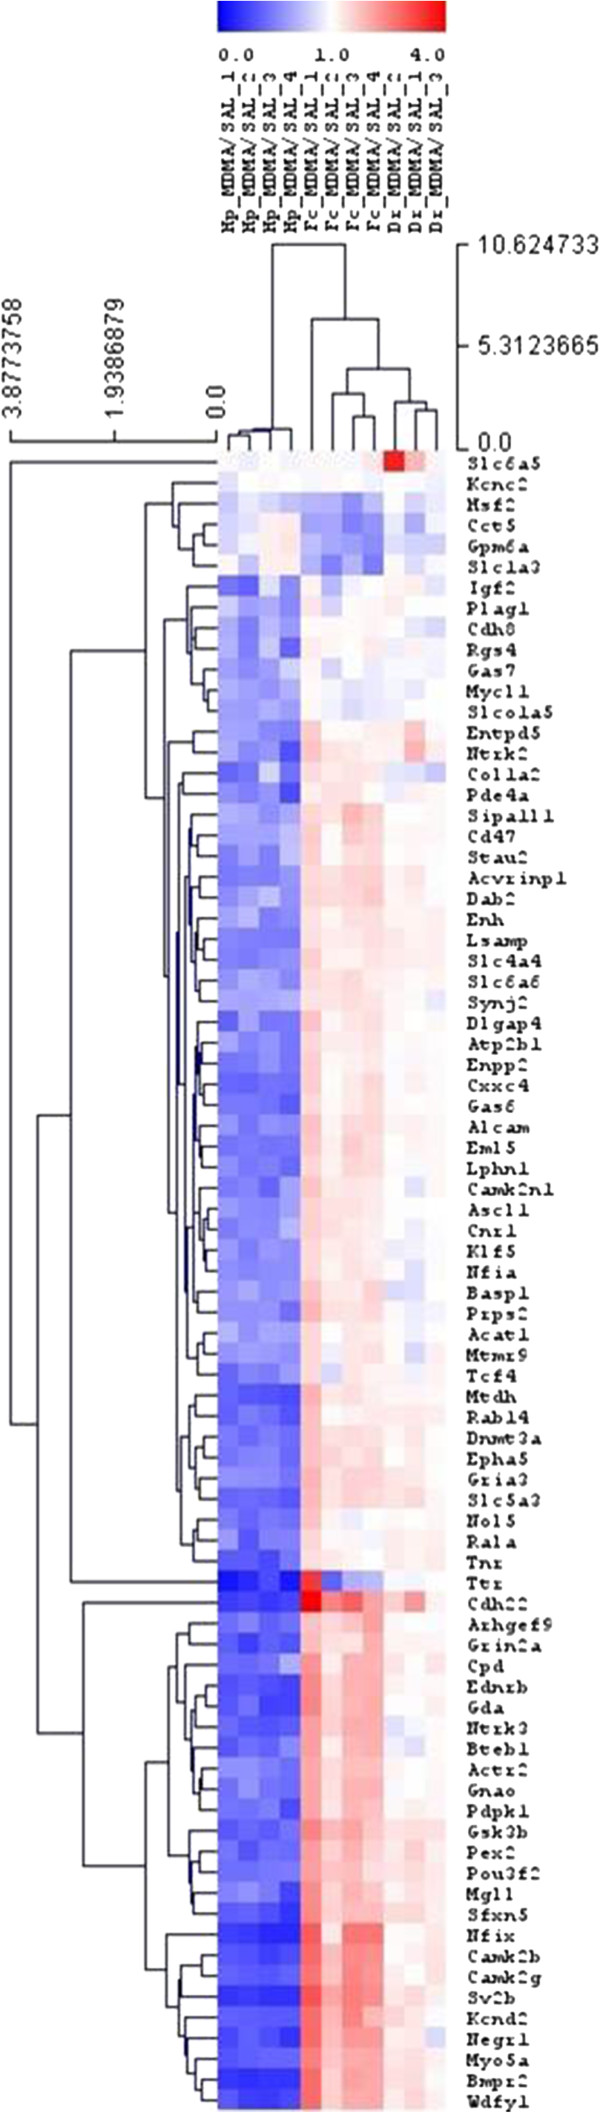
Correlation between the microarray and the Fluidigm GEx PCR array data. The figure summarizes the correlation between the logarithmic microarray data and the validation results for both the 200 ng and 500 ng samples. For validation purposes we used the polymerase chain reaction-based (PCR-based) Fluidigm GEx array with 19 genes and upon receiving the results, the numerical analysis was performed with the inbuilt corr.test function of the R statistical computing program. The results are in agreement with the commonly observed decreasing accuracy of the fold change values of the microarray method at the higher and lower ends. The correlation coefficients were 0.619 and 0.610 for the 200 ng and 500 ng samples, respectively. Red line represents the regression line.